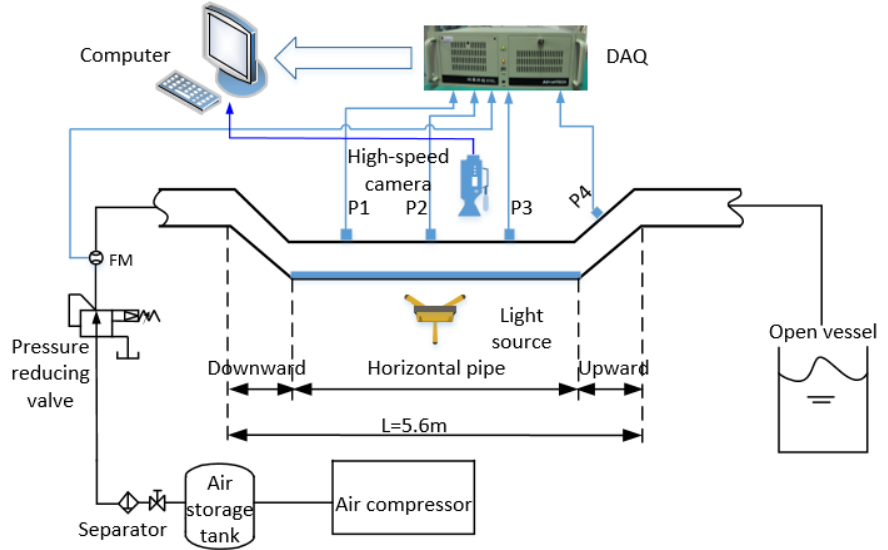
Figure 2. Schematic diagram of experiment.